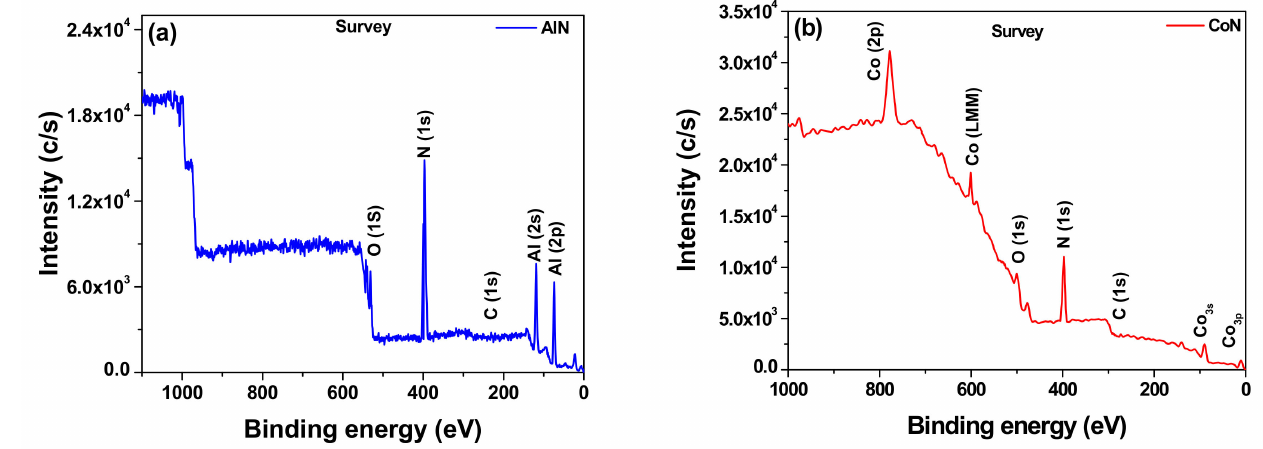
Figure 3. XPS depth spectra of the coatings: ( a ) AlN single layer and ( b ) CoN single